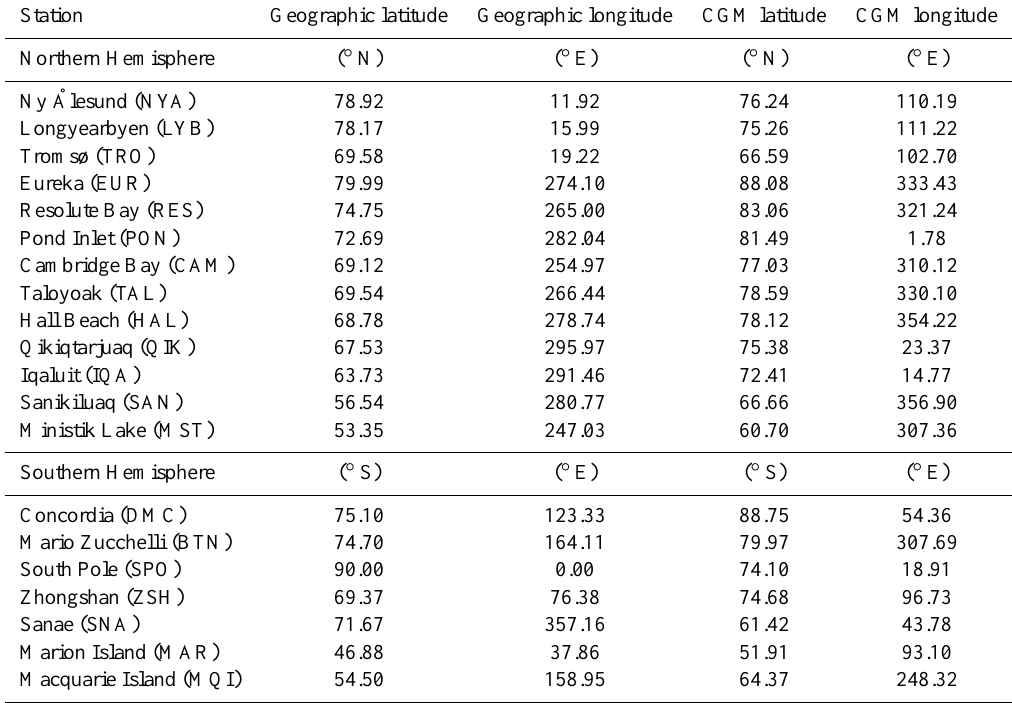
Table 1. Geographic and corrected geomagnetic coordinates of GISTM